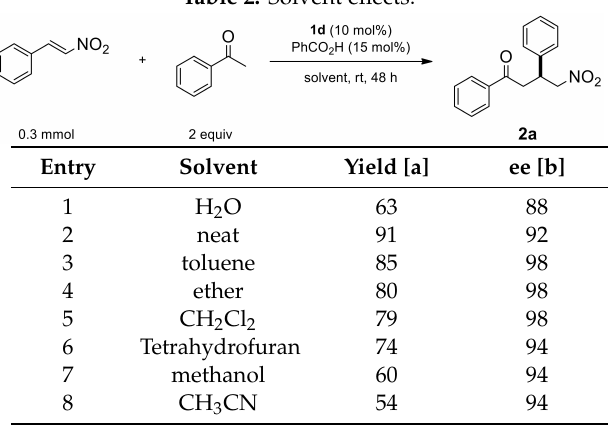
Table 2. Solvent e ff